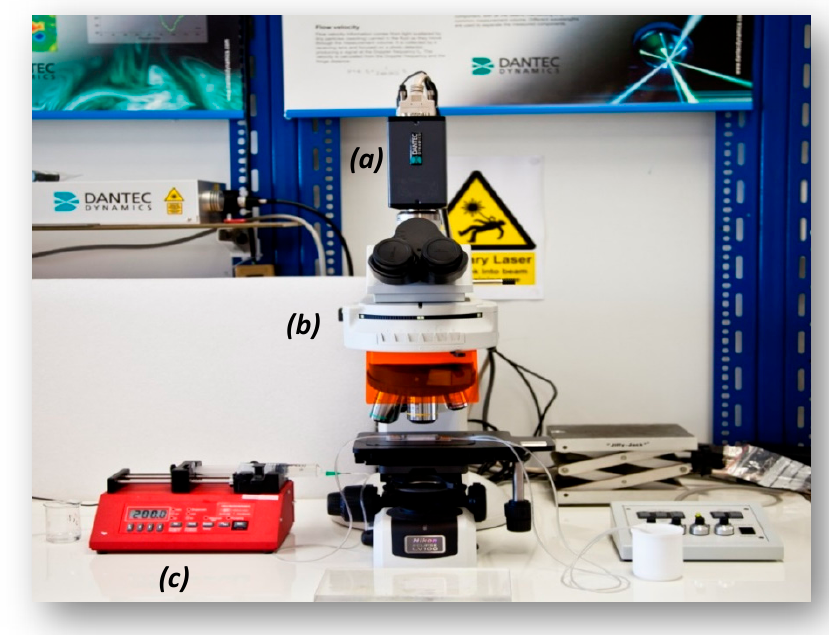
Figure2. Micro-particleimagevelocimetry( µ -PIV)experimentalsetupusedinthisstudy( a ): high-speed camera, ( b ): microscope, ( c ): syringe Figure 2. Micro-particle image velocimetry ( μ -PIV) experimental setup used in this study ( a ): high-speed camera, ( b ): microscope, ( c ): syringe pump.